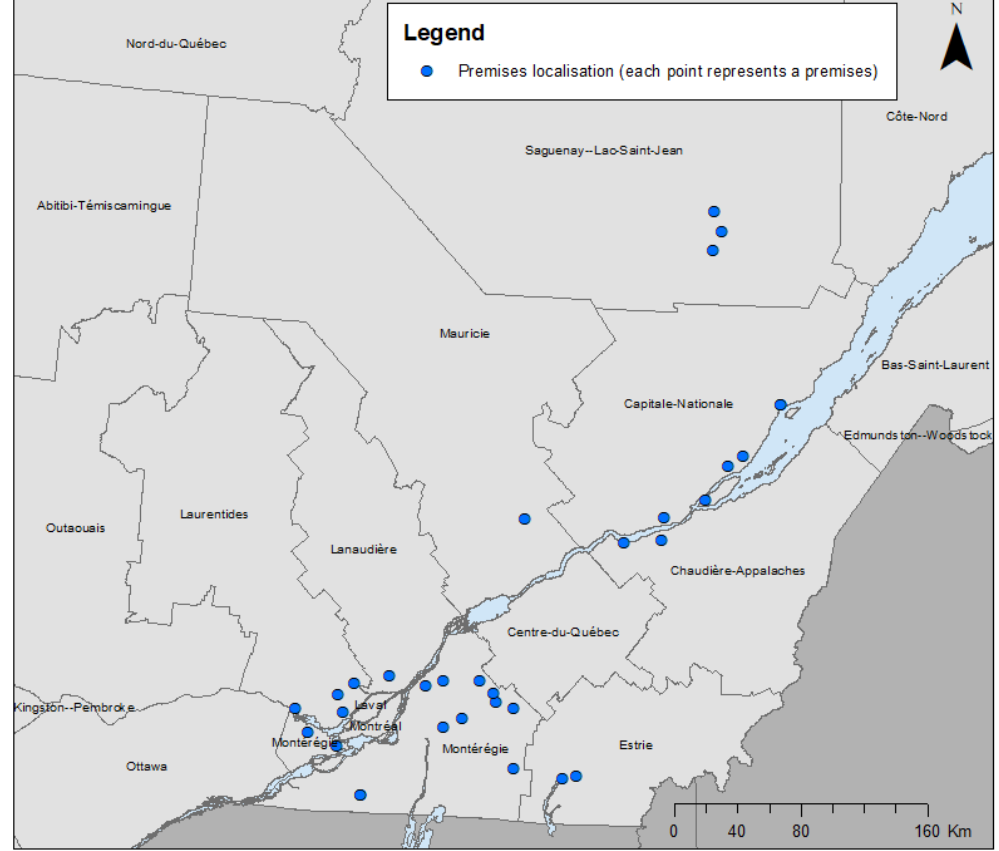
Figure 1. Geographical distribution of the sampled premises (based on center point of their 6-digit postal code) over the administrative regions of the province of Quebec in a cross-sectional study of 209 healthy adult horses in 32 premises performed in 2015 and 2016. Two premises in Capitale-Nationale and two premises in Monteregie were very close, and therefore are overlapping on the map. Mapping was performed in ArcGIS version 10.6, using reference maps from Statistics Canada (2016 census). Among the sampled horses, 48% were geldings, 49% were female and 3% were stallions. The mean age was 12 years old with a range from 2 to 30 years